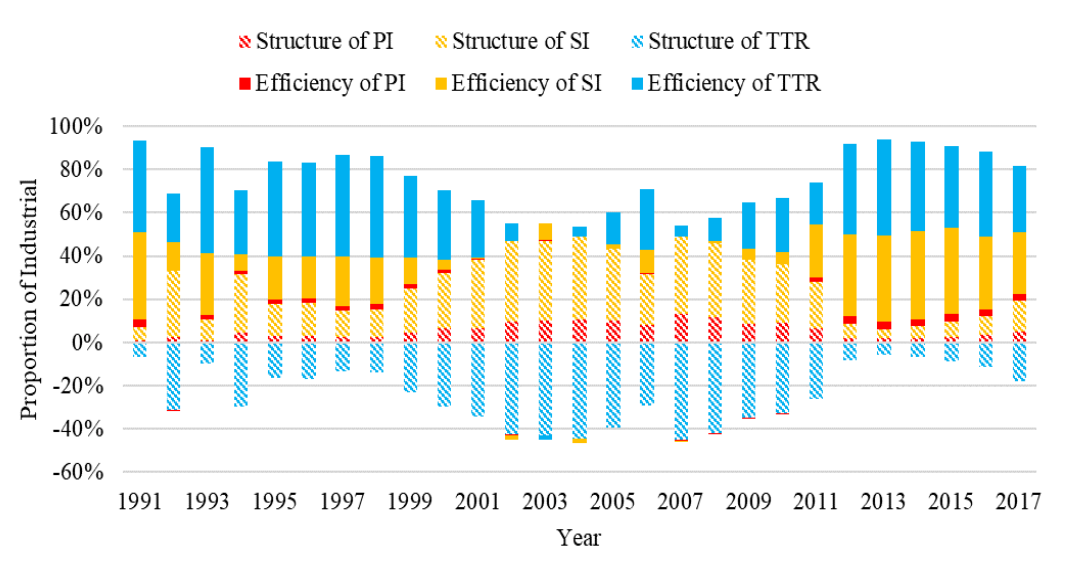
Figure 3. The proportion of structural factors and efficiency factors of energy consumption CO 2 emission intensity (ECCEI).